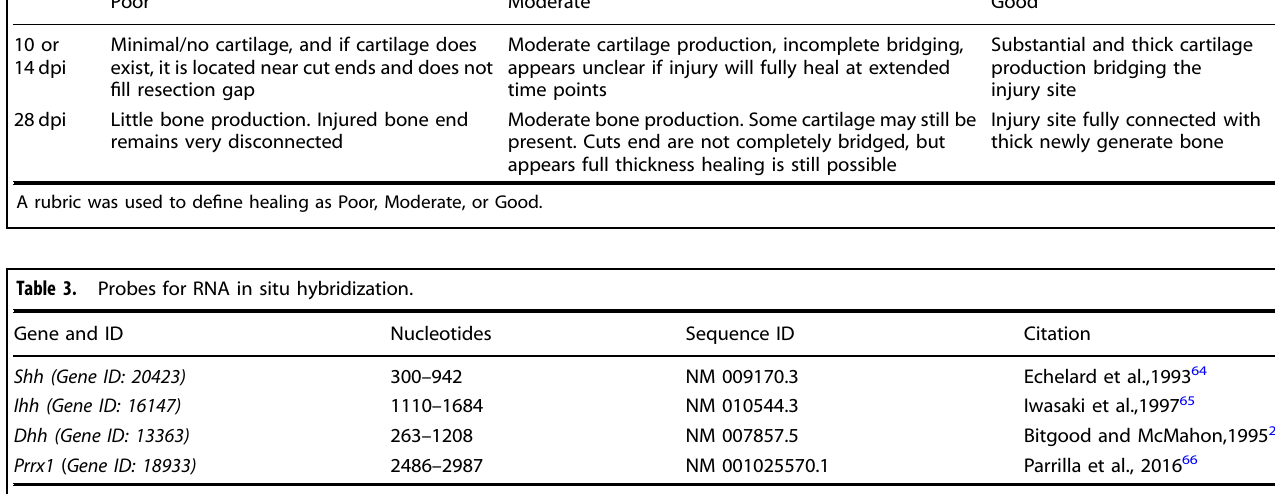
Moderate cartilage production, incomplete bridging, appears unclear if injury will fully heal at extended time points